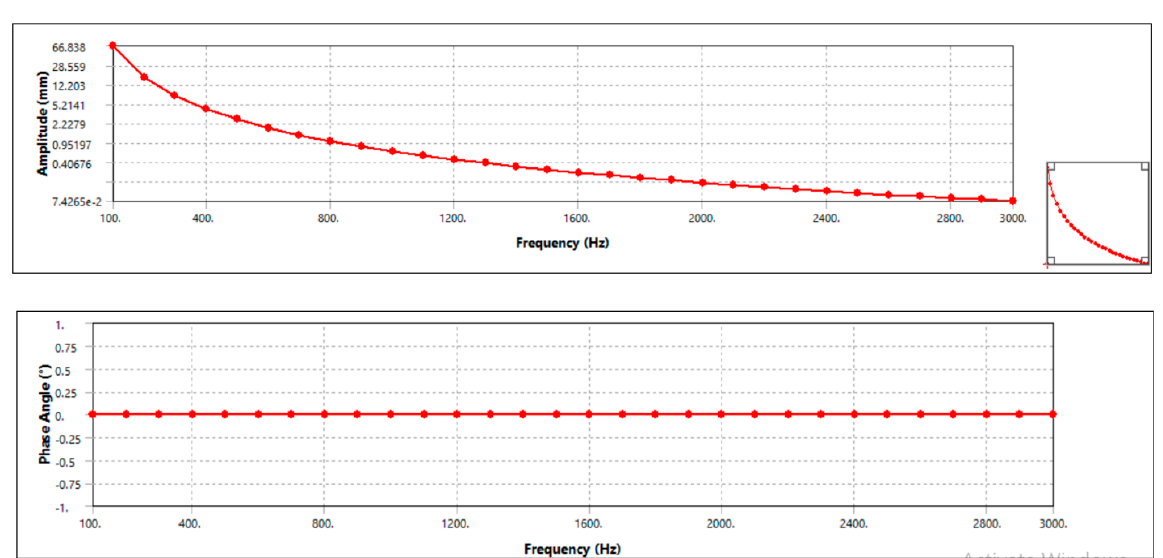
Figure 9. Harmonic response of AMNCs disc.